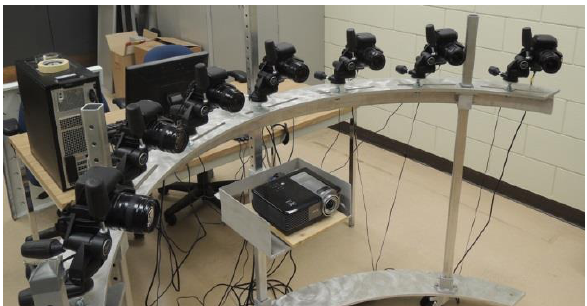
Figure 3. Multi-camera photogrammetric system consisting of seven DSLRs attached to a metal